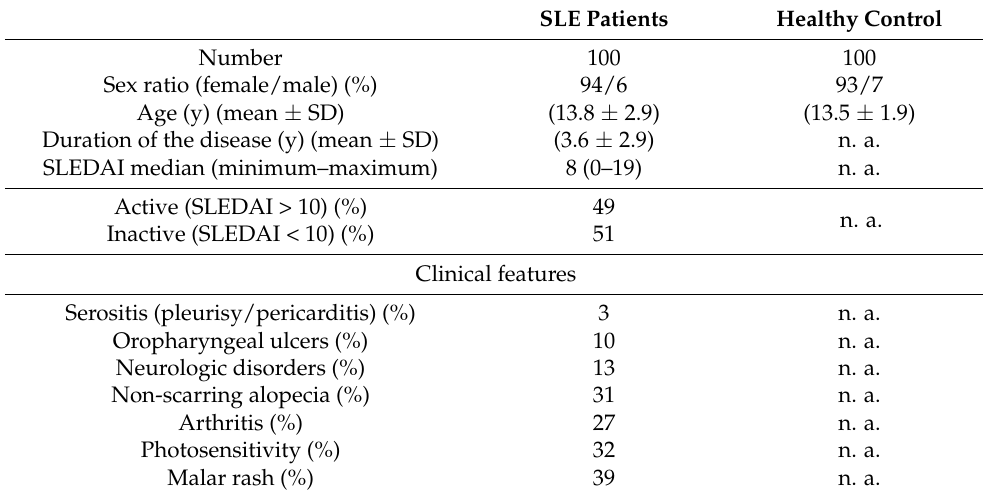
Table 1. Clinical and demographic characteristics of the healthy control subjects and SLE (systemic lupus erythematosus)